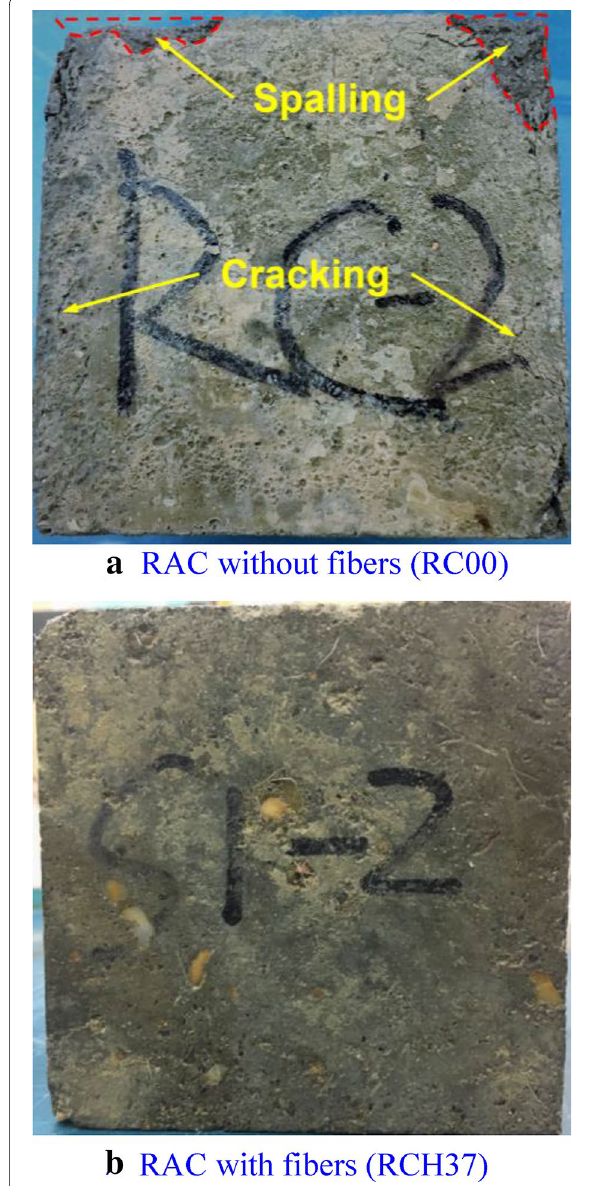
Fig. 7 Apparent damage of RAC after mechanical loading and salt-solution freeze–thaw cycles: a RAC without fibers, and b RAC with